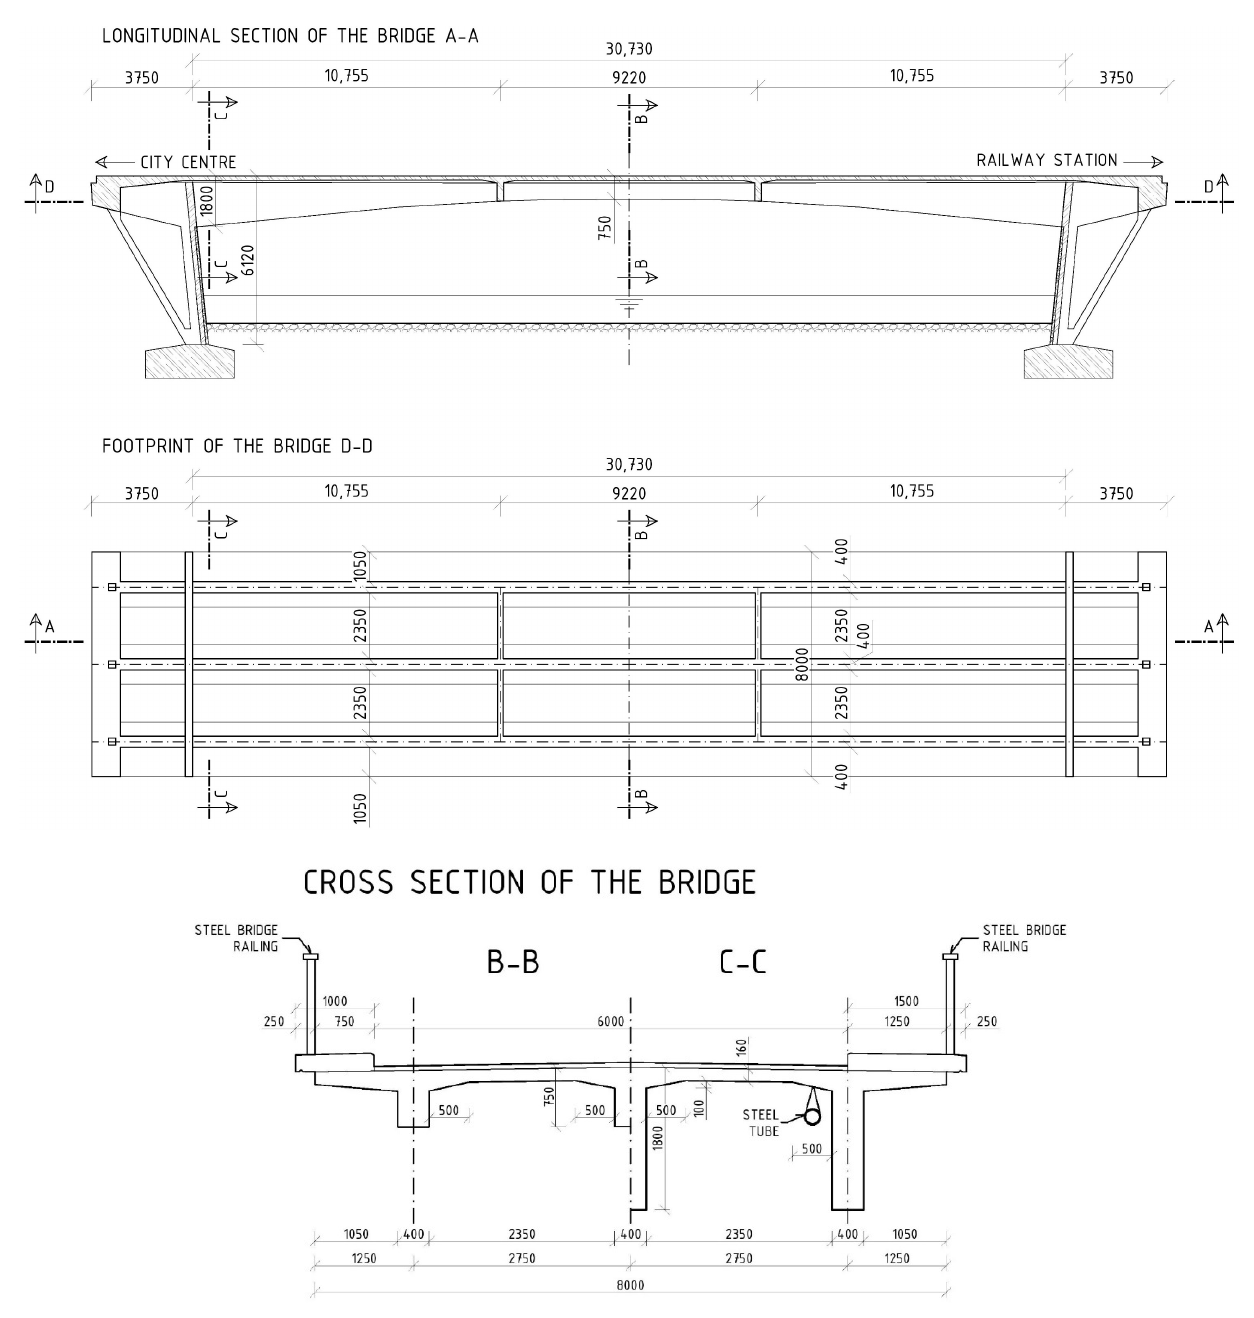
Figure 4. Schemes of the bridge (dimensions are in [mm]). Table 1. Schmidt hammer